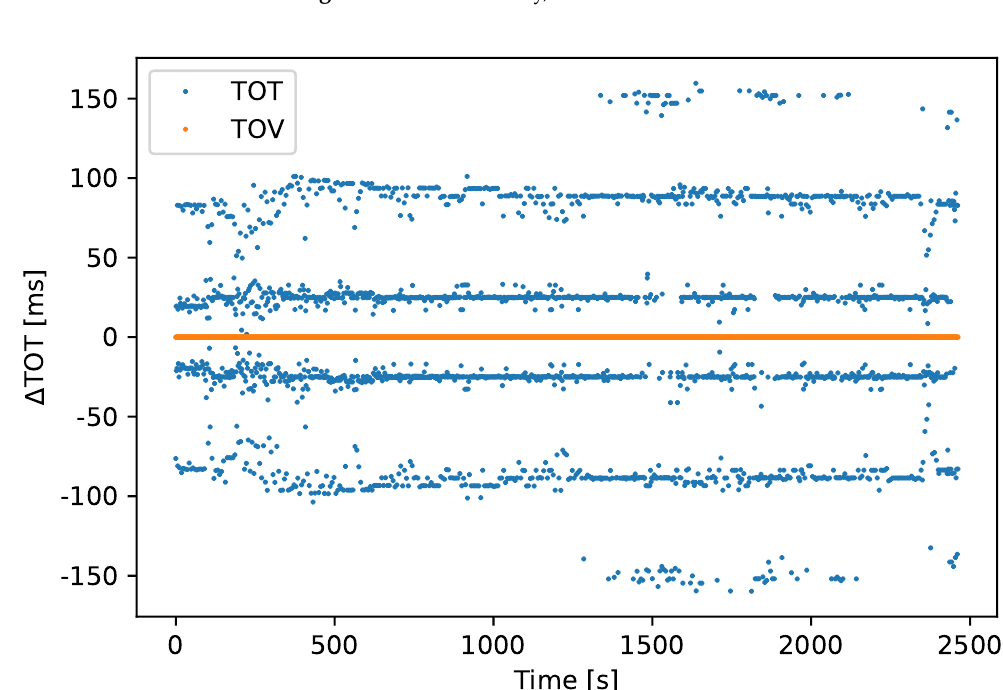
Figure 13. TOT accuracy vs. TOV accuracy, in